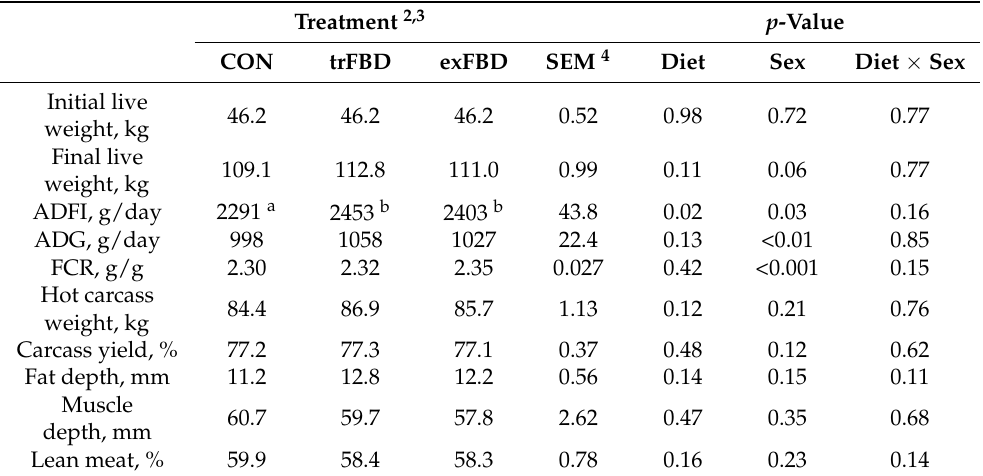
Table 5. Effect of partially replacing dietary soybean meal with field beans treated with propionic acid (trFB) and extruded trFB (exFB) on growth performance and carcass quality of grow finisher pigs ( n = 10 pairs of pigs/treatment) 1 .